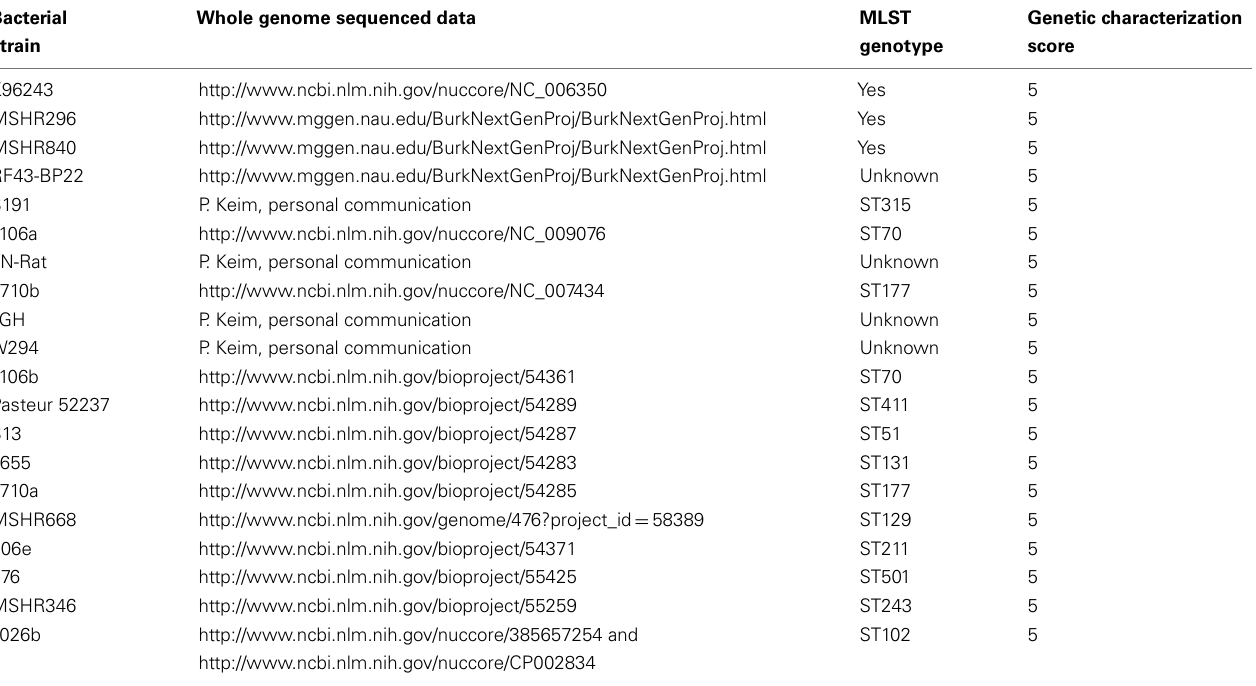
Table 4 | Burkholderia pseudomallei strains with genome